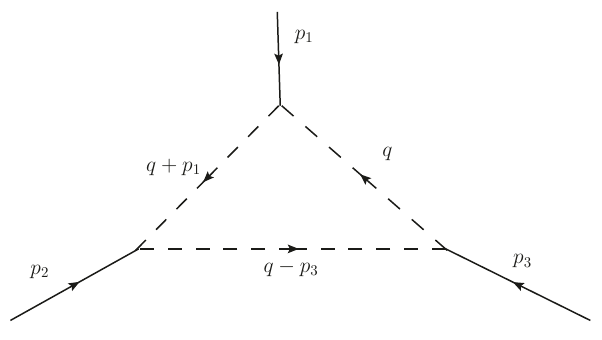
Figure 14. This diagram de(cid:12)nes ~ S 3 ( p 1 ; p 2 ; p 3 ) in